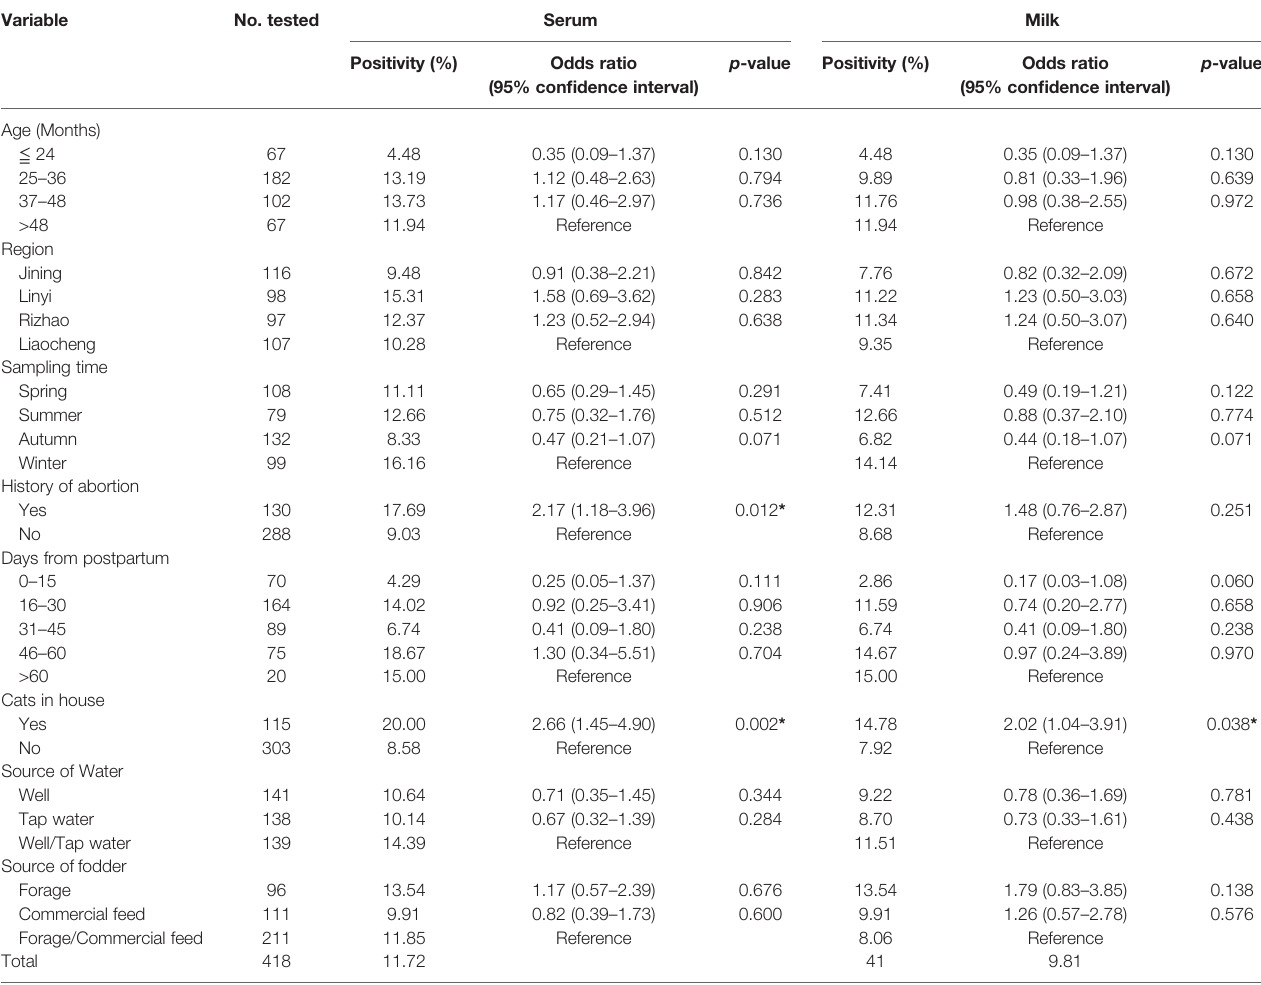
TABLE 2 | Univariate analysis of the variables associated with T. gondii prevalence in the serum and milk samples of the domestic donkeys tested by ELISA. Variable No.